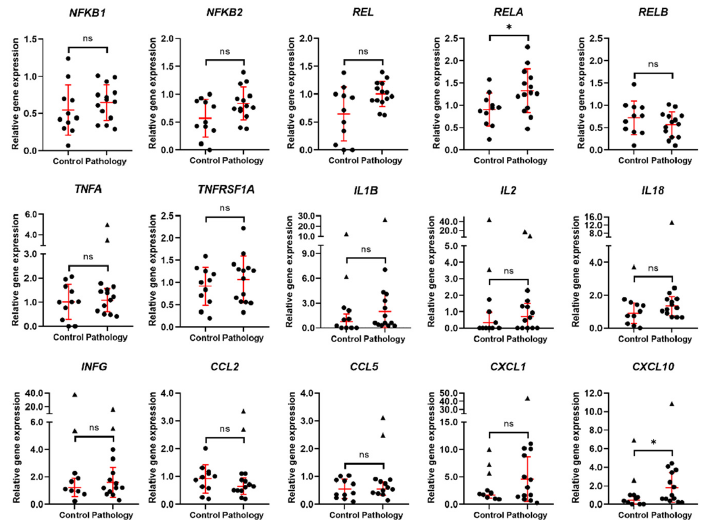
Figure 3. Expression of immune response and inflammation-related genes. Results are presented as mean ± standard deviation (red lines); triangle data points represent outliers based on ROUT (Q = 5%). In the control group, n = 11; in the pathology group, n = 14. * p ≤ 0.05; ns—not statistically significant, based on the Mann–Whitney U test.